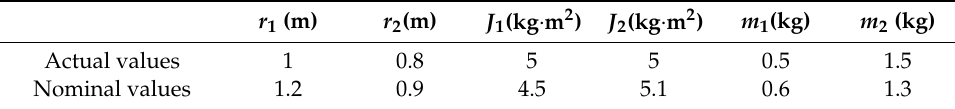
Table 1. Dynamic parameter